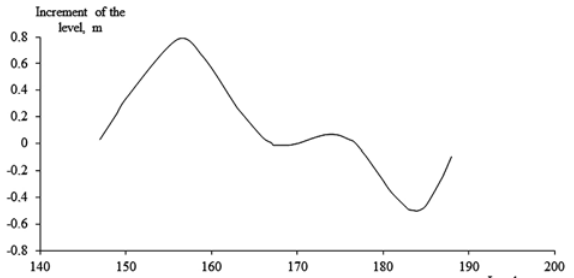
fig. 4. Polynomial regression of the 8th order on an absolute